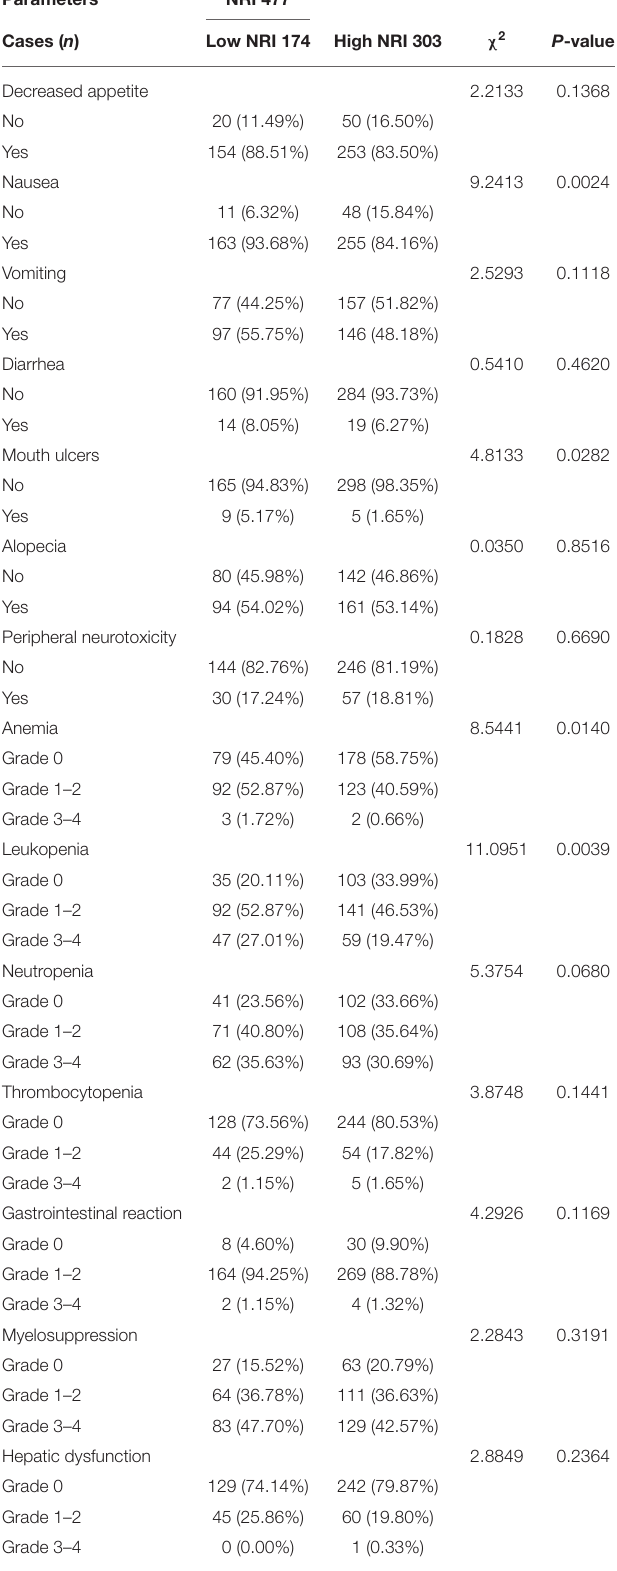
TABLE 5 | The correlation between NRI and toxicity